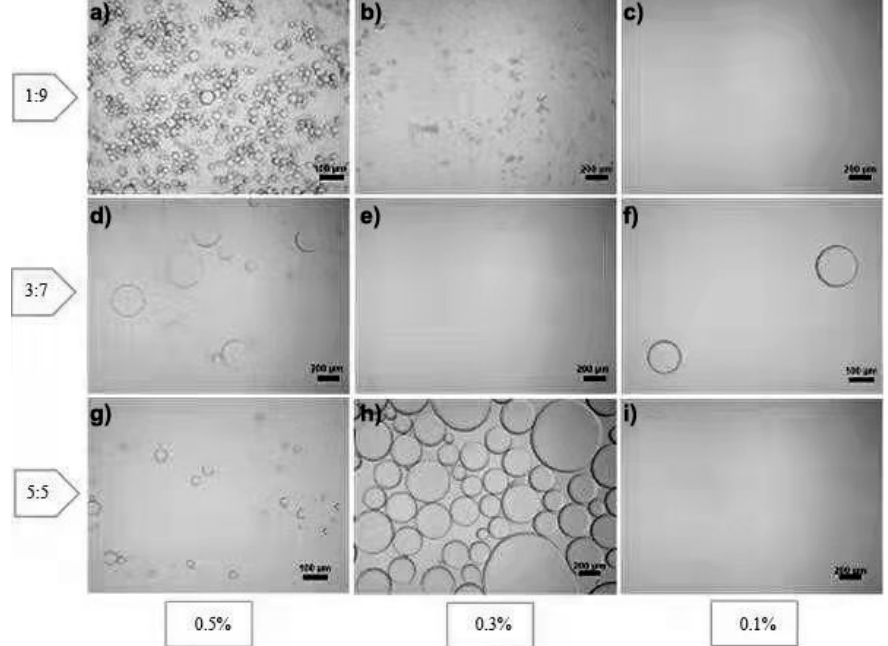
Figure 7. Optical micrographs of the Pickering emulsions of hexane in RLC suspension. Optical micrographs show that ( a – c ) the O/W ratio is 1:9, the oil phase is n-hexadecane, and the water phase is sisal suspensions, where the contents of sisal suspensions were 0.5%, 0.3%, and 0.1%, respectively. ( d – f ) Optical micrographs show that the O/W ratio is 3:7, the oil phase is n-hexadecane, and the water phase is sisal suspensions, where the contents of sisal suspensions were fixed to 0.5%, 0.3%, and 0.1%, respectively. ( g – i ) Optical micrographs show that the O/W ratio is 5:5, the oil phase is n-hexadecane, and the water phase is sisal suspensions, where the contents of sisal suspensions were 0.5%, 0.3%, and 0.1%, respectively.